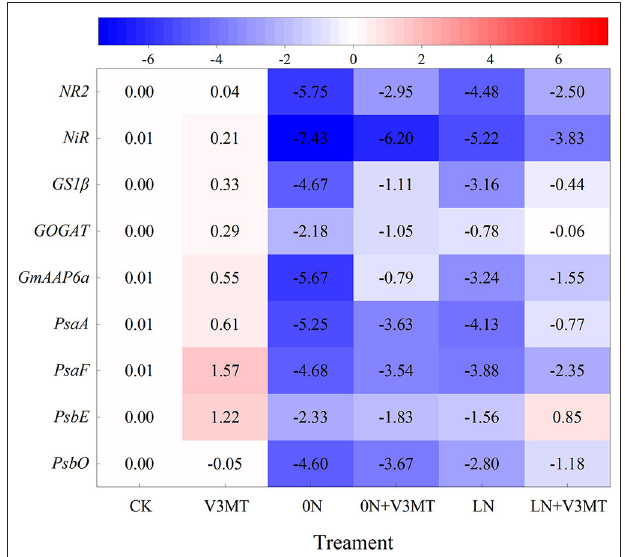
FIGURE 11 | The effect of exogenous melatonin on the relative expressions of nitrate reductase gene ( NR2 ), nitrite reductase gene ( NiR ), glutamine synthetase gene ( GS1 β ), glutamate synthase gene ( GOGAT ), gene related to amino acid assignment ( GmAAP6a ), and genes related to photosynthesis ( PsaA, PsaF, PsbE, PsbO ) in plant leaves under three N levels. The abbreviated meaning of each treatment is the same as in Figure 3 . Taking the average value of the actin gene and CK expression as reference, the values were the average of 2 − ( 11 CT) presented.